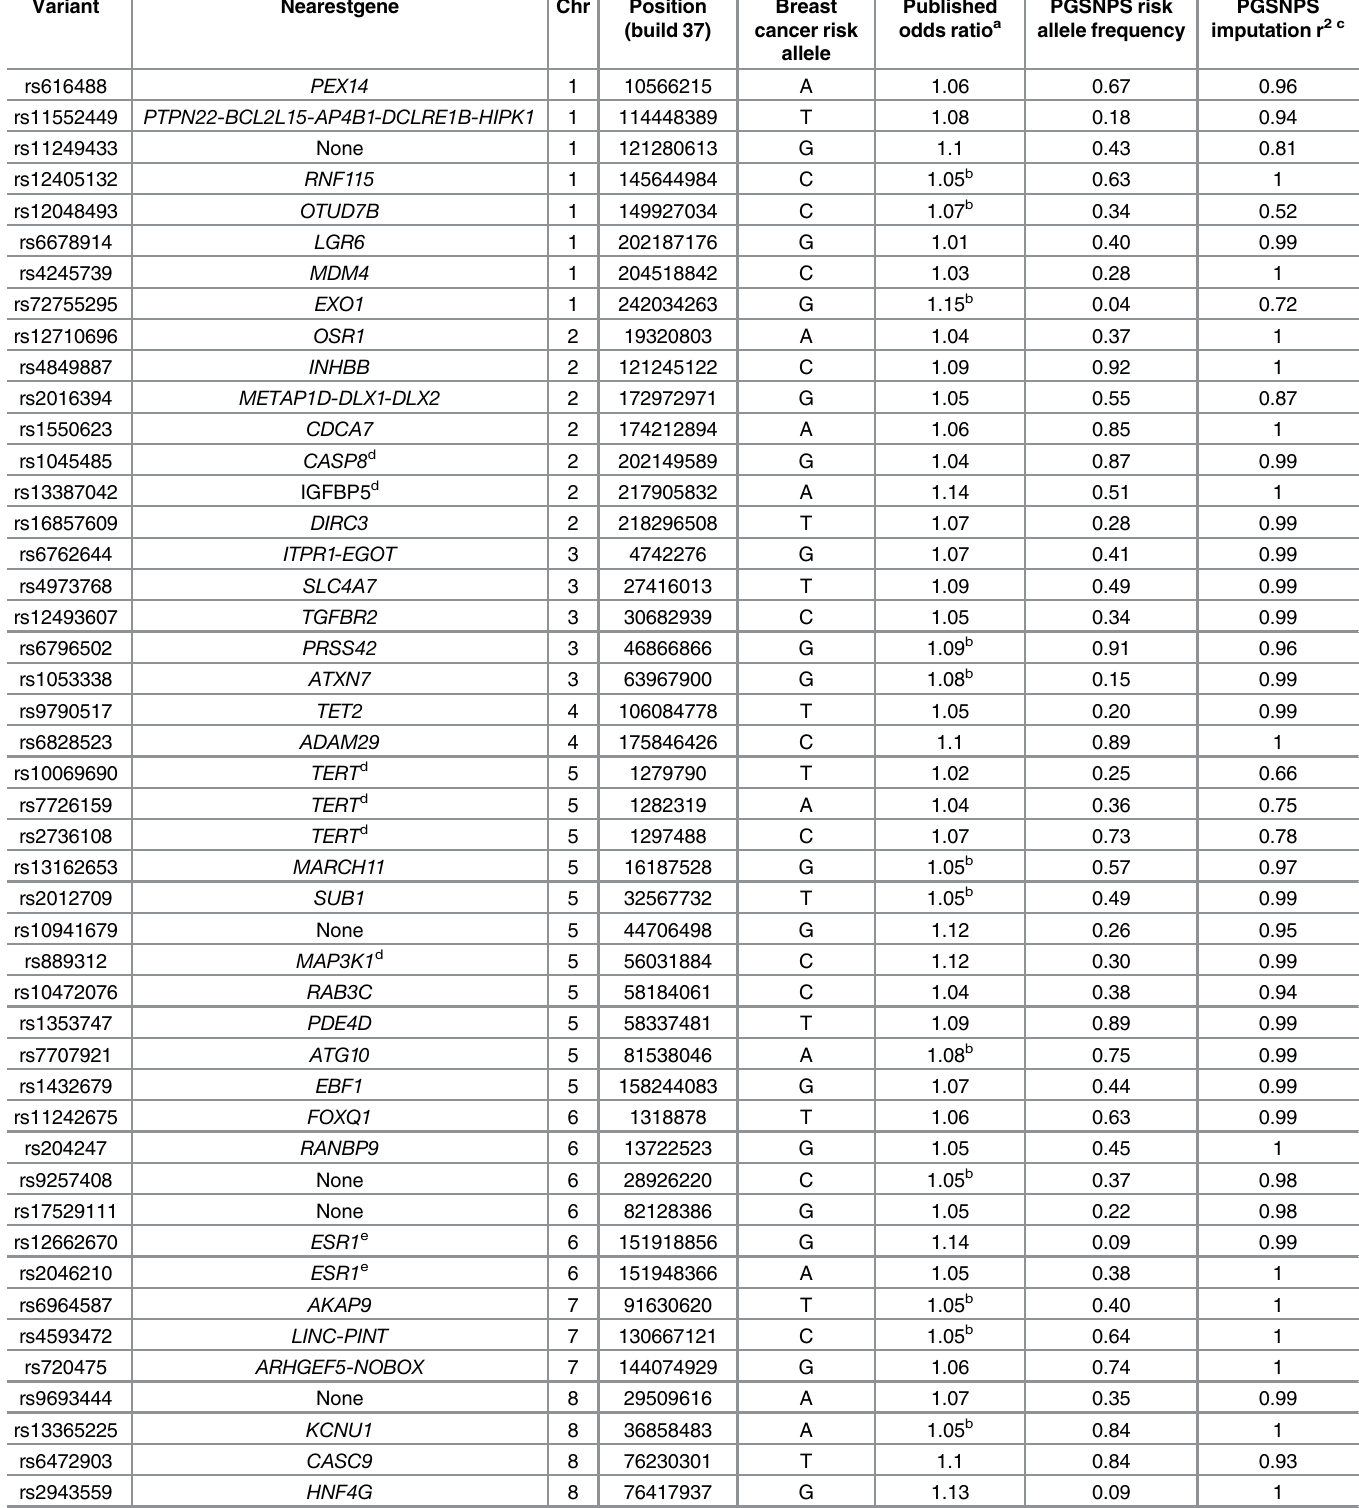
Table 1. Genetic variants known to influence risk of breast